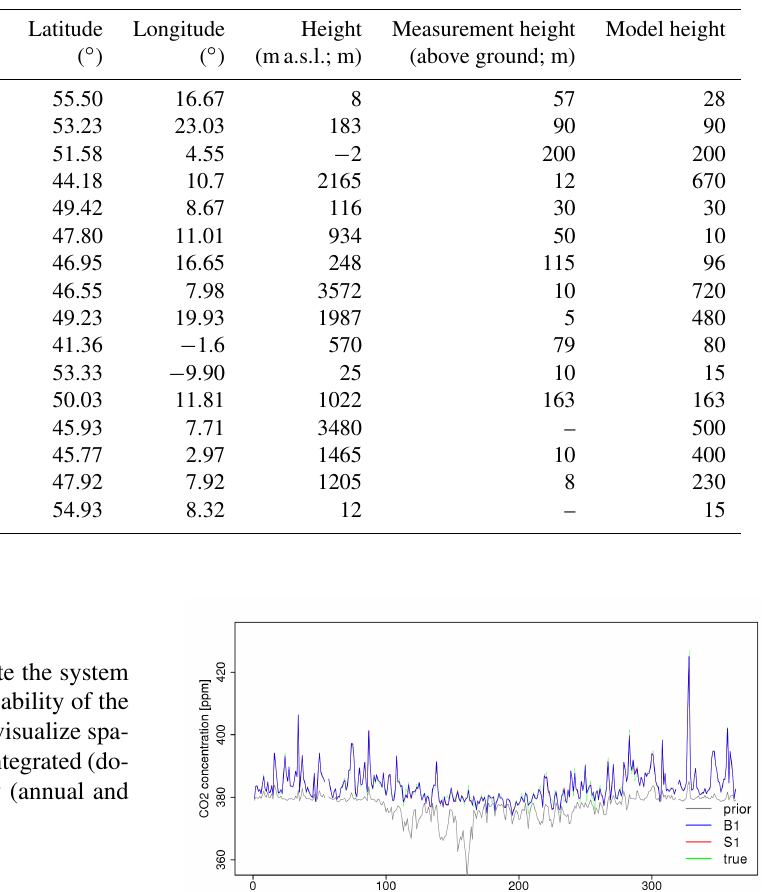
Table 2. Information on the stations used for the regional inversions. Same network applied for the synthetic data inversions and the real-data inversions in Kountouris et al. (2018). In the first column the term “type” stands for continuous (C) or flask (F) data.